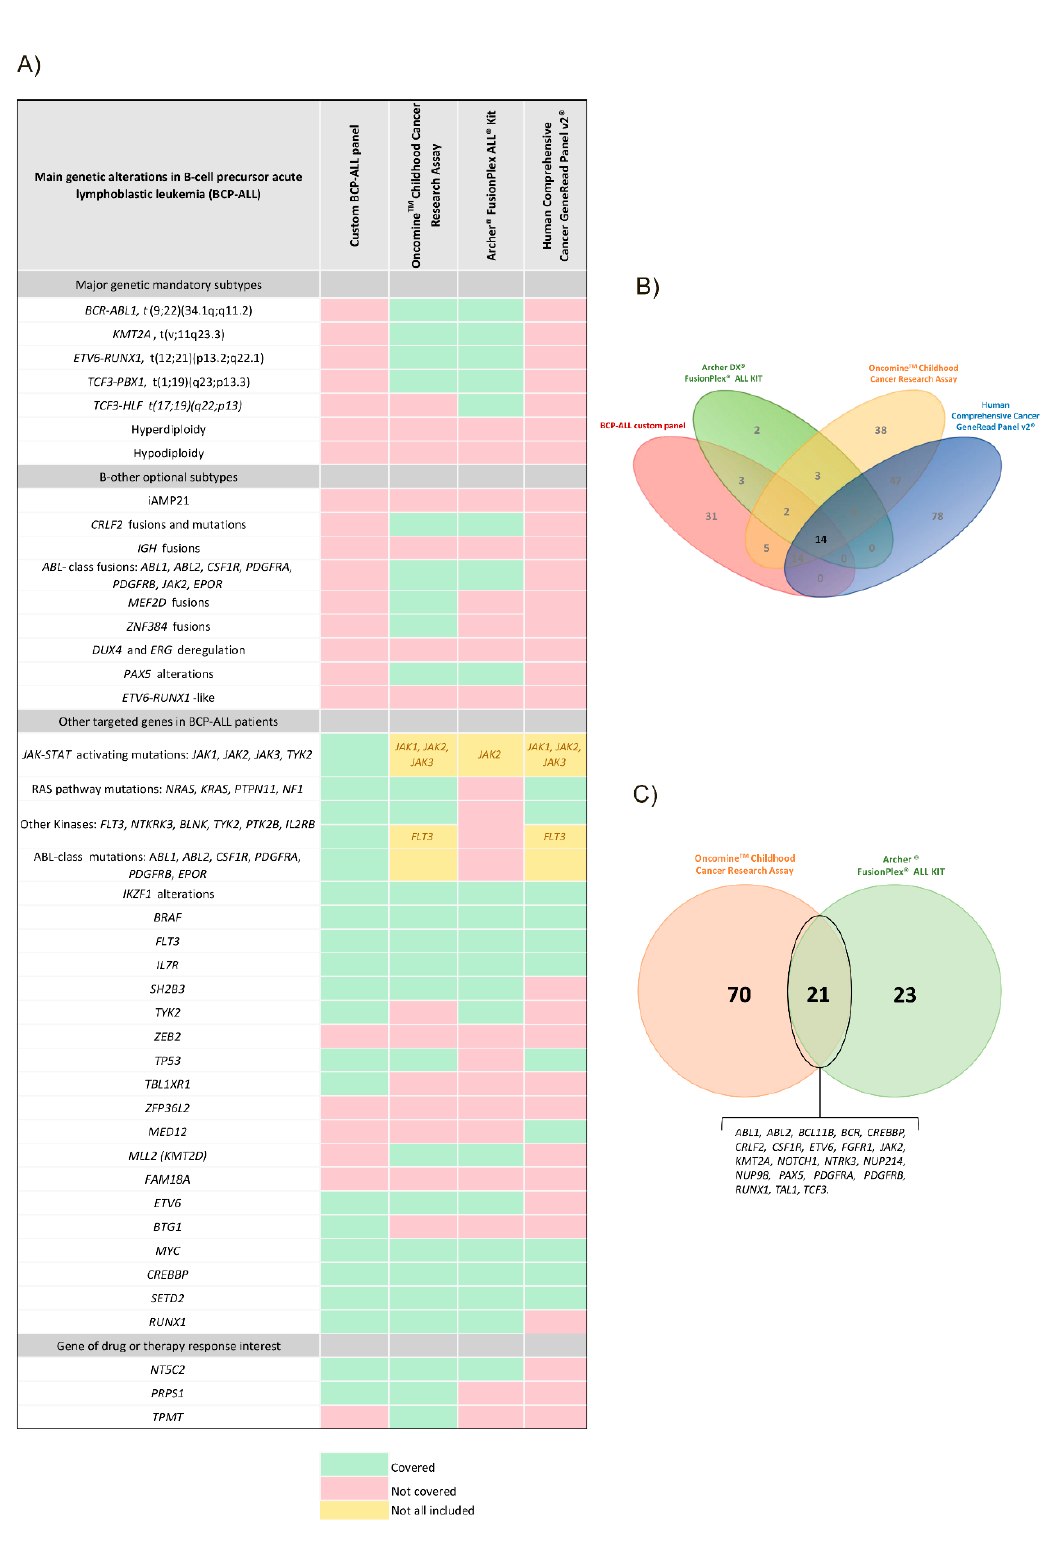
Figure 3. Gene content of the different targeted panels. ( A ) Approach of the different panels to assess the main genetic alterations in BCP-ALL. ( B ) Overlapping gene content in the different Next Generation Sequencing-targeted compared panels. ( C ) Overlapping fusion content in the Oncomine TM Childhood Research Assay and Archer ® FusionPlex ® ALL kit.